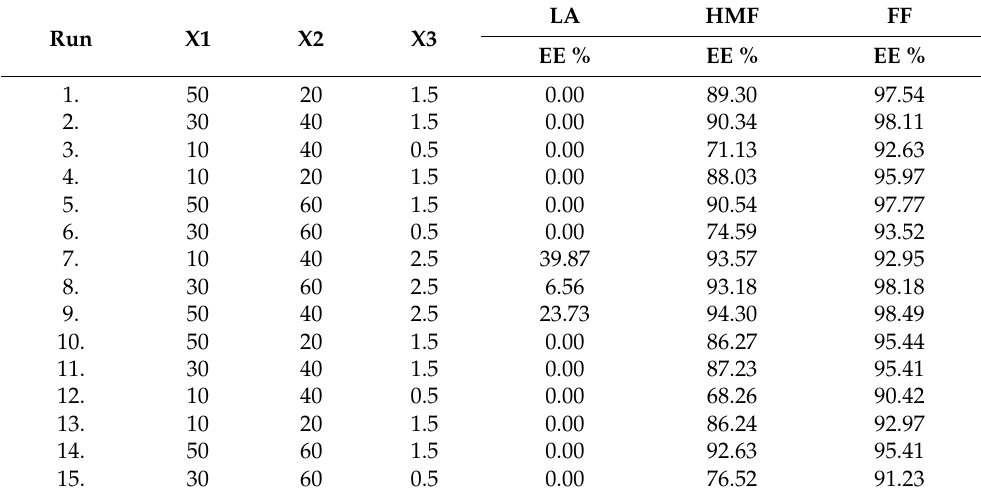
Table 3. Box–Behnken experimental design; X3 defined as V Gu :V PFB (pure guiacol).